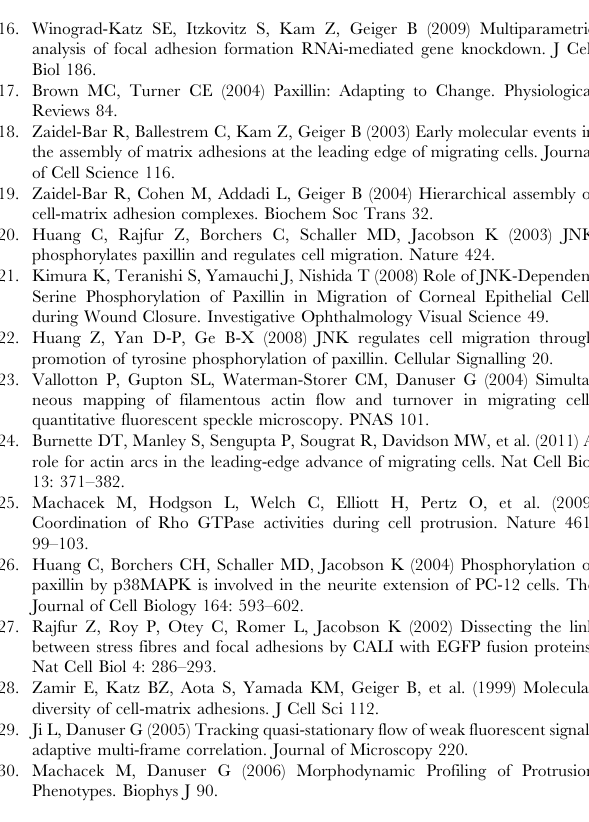
Figure S12 Evaluation of the tracking algorithm’s ability to follow adhesions of various sizes and speeds. (A) A sample frame from the simulated adhesion motion experiment where the adhesions were moved at 1 pixel per frame. The top row of adhesions of only a single pixel could not be followed. (B) As the movement speed of the simulated adhesions increases, only larger adhesions can be reliably tracked. Figure S13 Evaluation of the rate and phase length detection algorithm using simulated focal adhesion images. (A and C) The predicted median assembly (A) and disassembly (C) rates were extracted correctly by the algorithm. (B and D) The predicted lengths of both the assembly (B) and disassembly (D) were also correctly identified by the algorithm. All the red lines indicate the expected values of the properties in each plot.